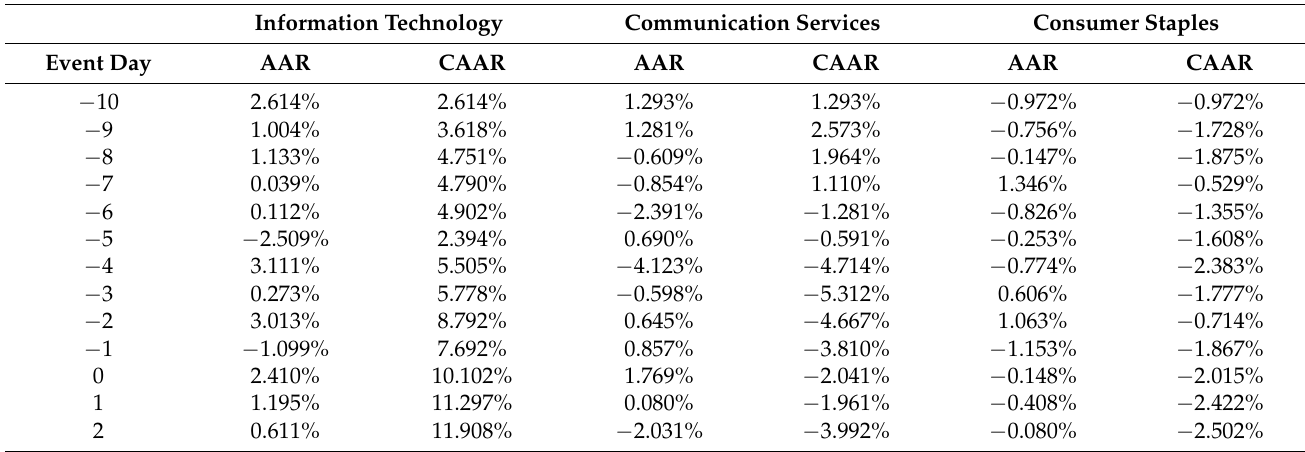
Table A3. Average abnormal returns and cumulative average abnormal returns for the Information Technology, Communi- cation Services, and Consumer Staples sectors for the “Moscow theater hostage crisis” geopolitical event and event window ( −